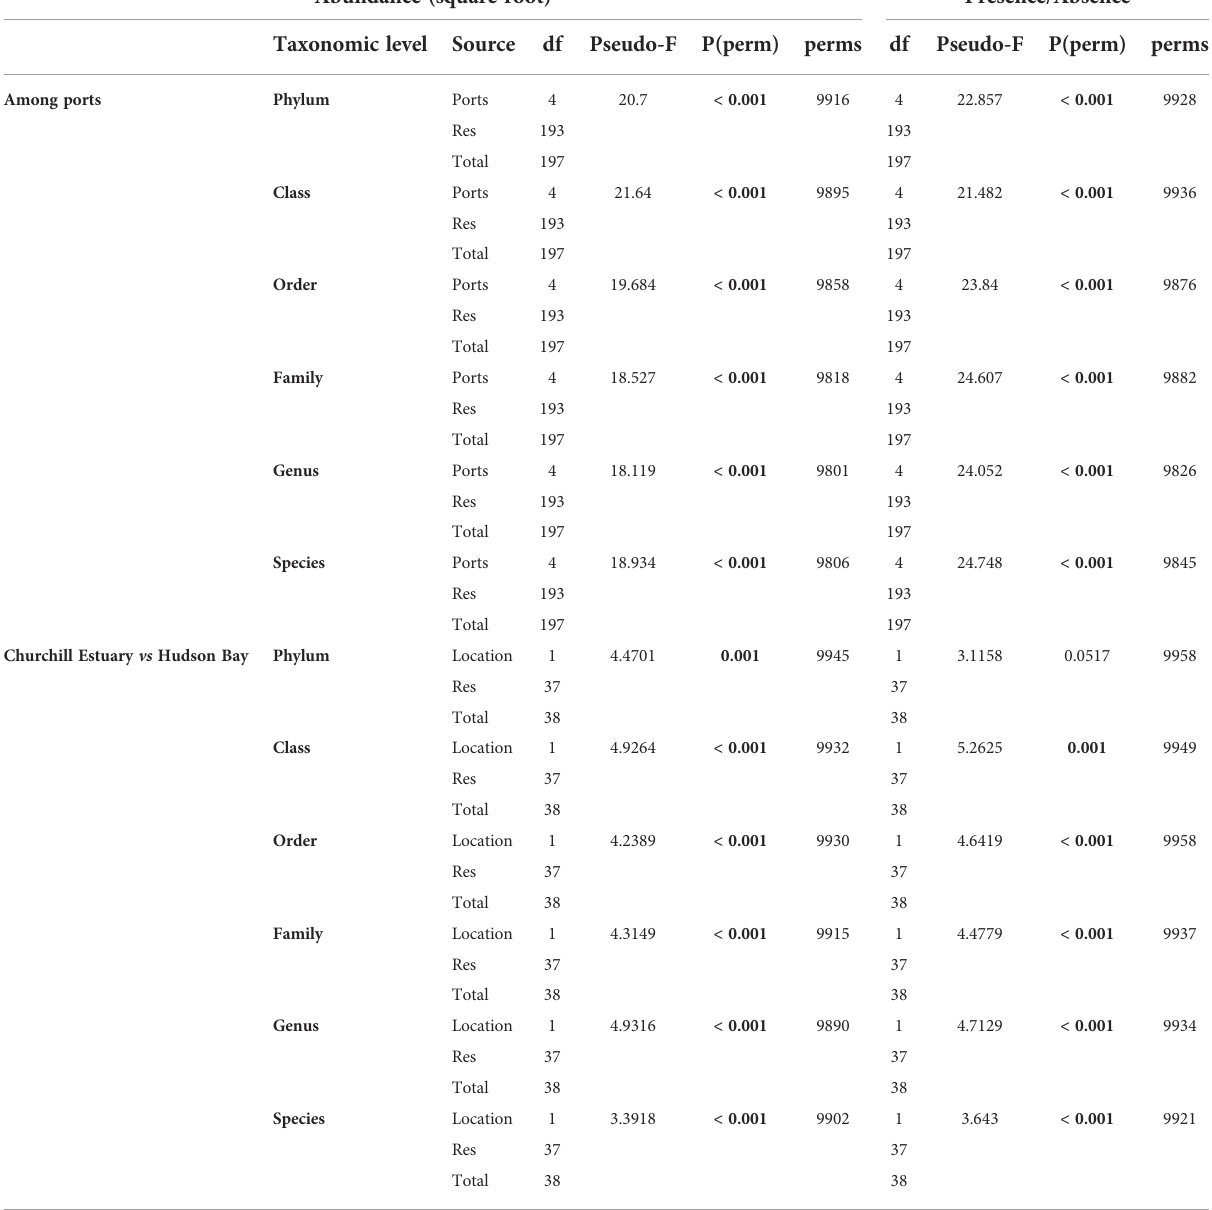
TABLE 3 Results of PERMANOVA analysis based on similarity matrices derived from square-root transformed abundance and presence/absence data. Abundance (square